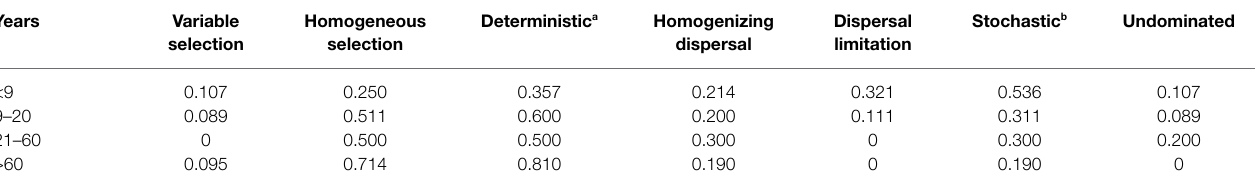
TABLE 2 | The relative contributions of ecological assembly processes across successional